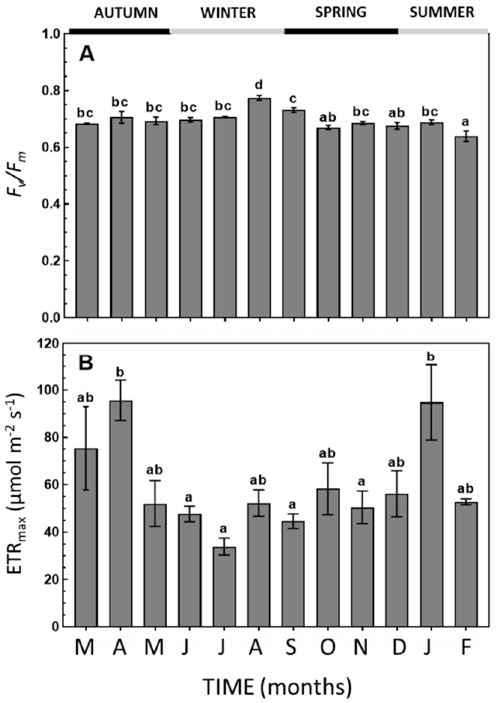
Figure 5. ( A ) Maximal quantum yield ( F v /F m ), and ( B ) maximal electron transport rate (ETR max ) in L. spicata measured at Cochoa Beach, Viña del Mar, Chile, between autumn and summertime. Letters indicate significant differences after the Student Newman Keuls (SNK) test ( p < 0.05).